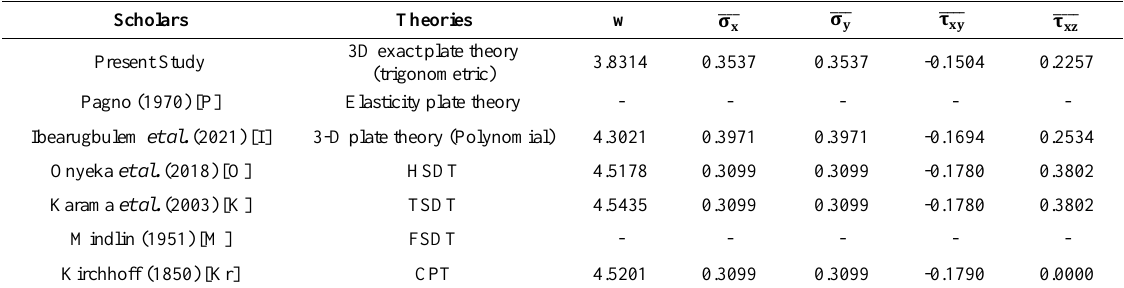
Table 5. Non dimensional forms of displacement and stresses of SSSS plate at aspect ratio of b/a = 1.0 and